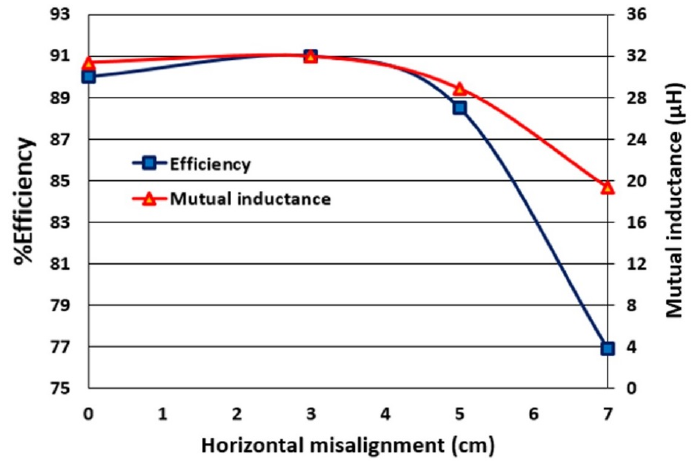
Figure 13. Experimental measurement of system efficiency and mutual inductance at different horizontal misalignments.